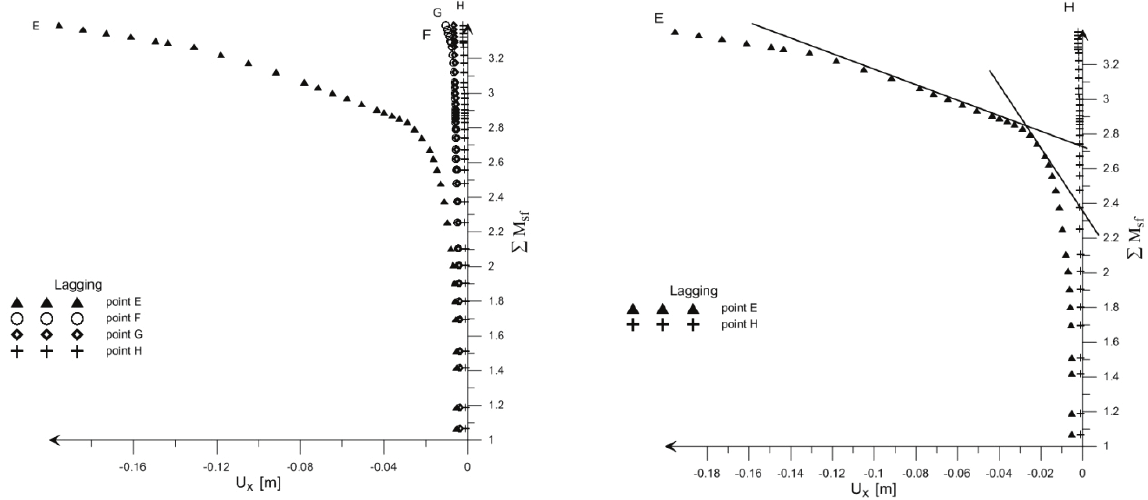
Fig. 15. Determining safety factor for measurement points in lagging (excavation depth 2 m)